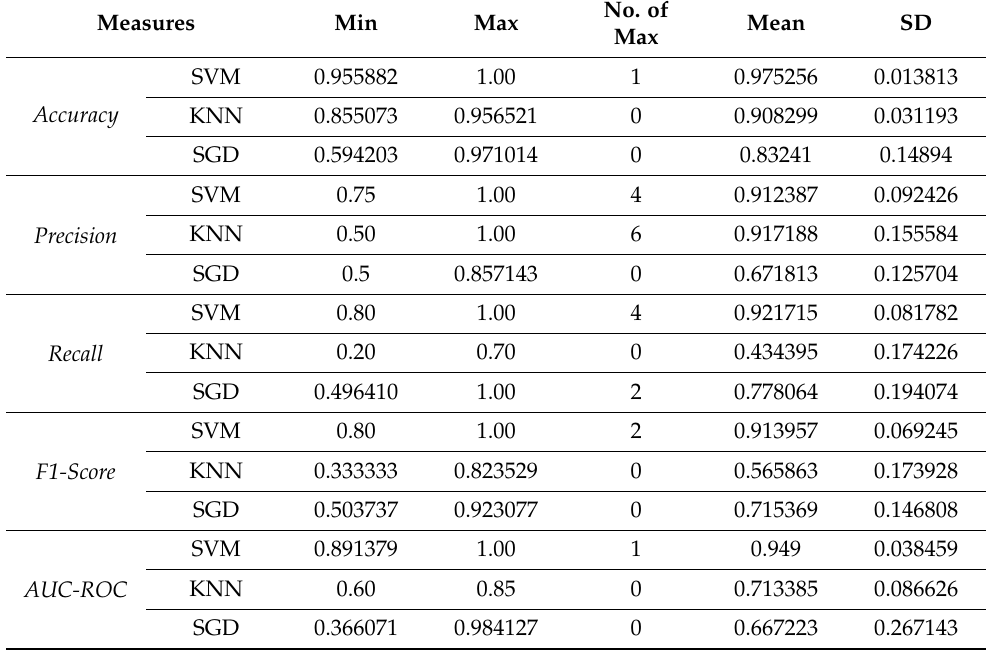
Table 9. Result Statistics of K-fold Cross-validation (K =